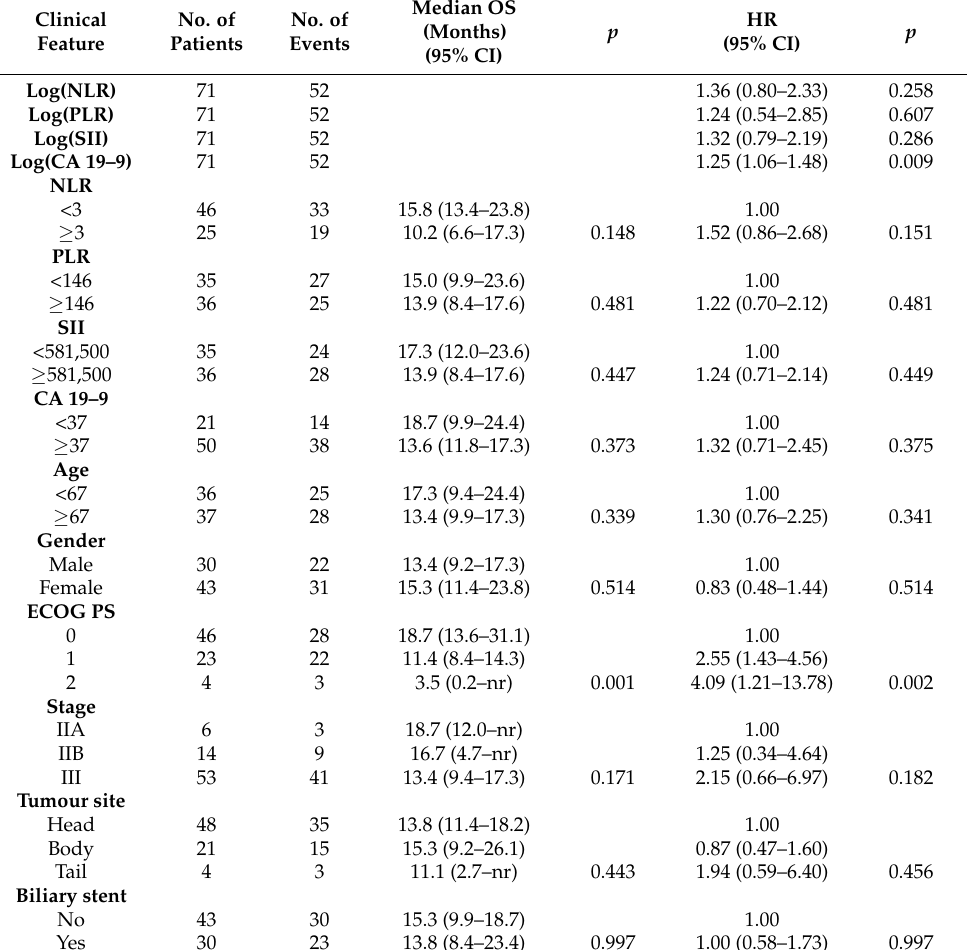
Table 4. Univariate analysis of overall